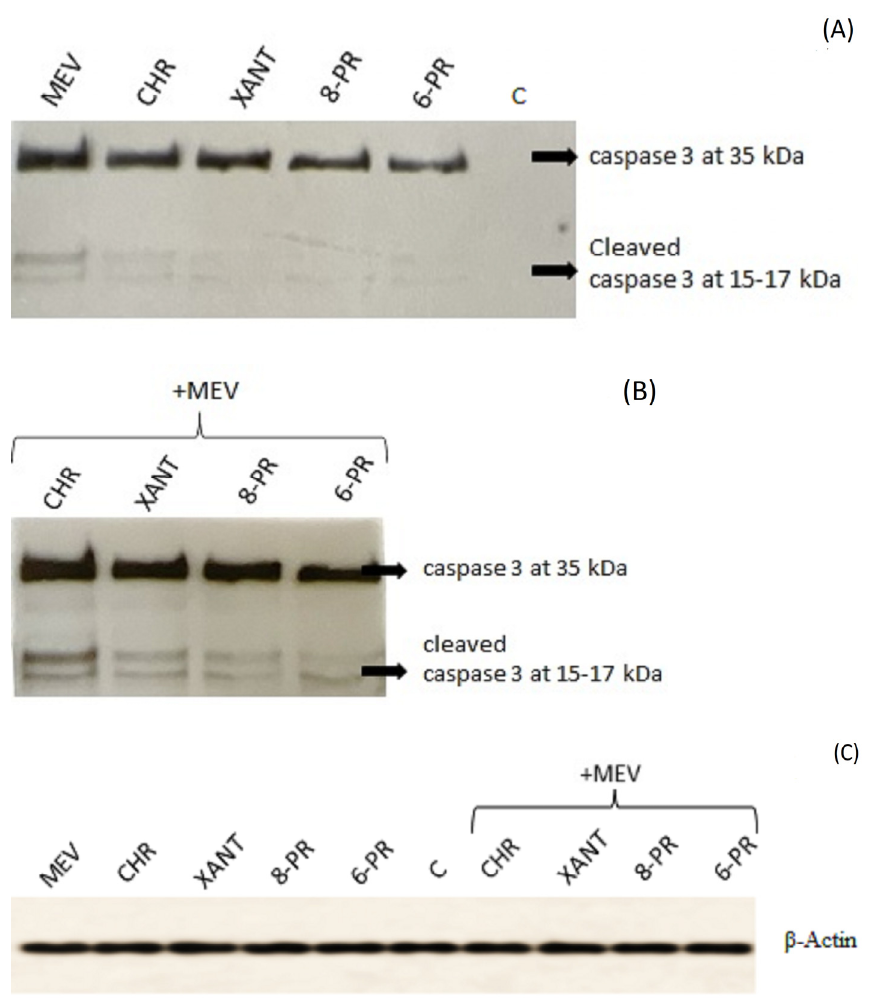
Figure 6. Analysis of caspase-3 protein expression in Jurkat T cells incubated for 48 h with mevastatin (MEV), CHR, XANT, 8 PR, and 6-PR as single agents ( A ), and with their combinations ( B ) for 48 h. Western Blot analysis of Jurkat cell extracts showing full length of cleaved caspase-3 (35 kDa) and cleaved caspase 3 (15–17 kDa); C-untreated cells. The molecular masses of the proteins are indicated on the right side of the gel. β -Actin was used as a reference protein ( C ).